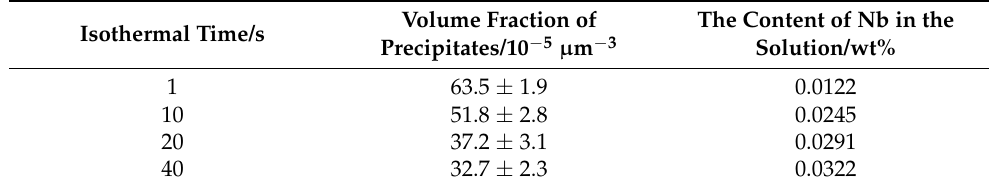
Table 3. Volume fraction of precipitates and the calculated values of Nb content in the solution at various isothermal times.